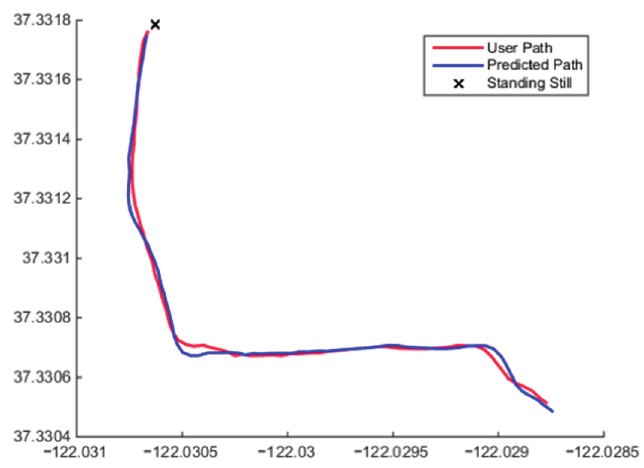
followed by switching (cid:2868) and Ω when target movement changes between (cid:2869) (cid:2870)